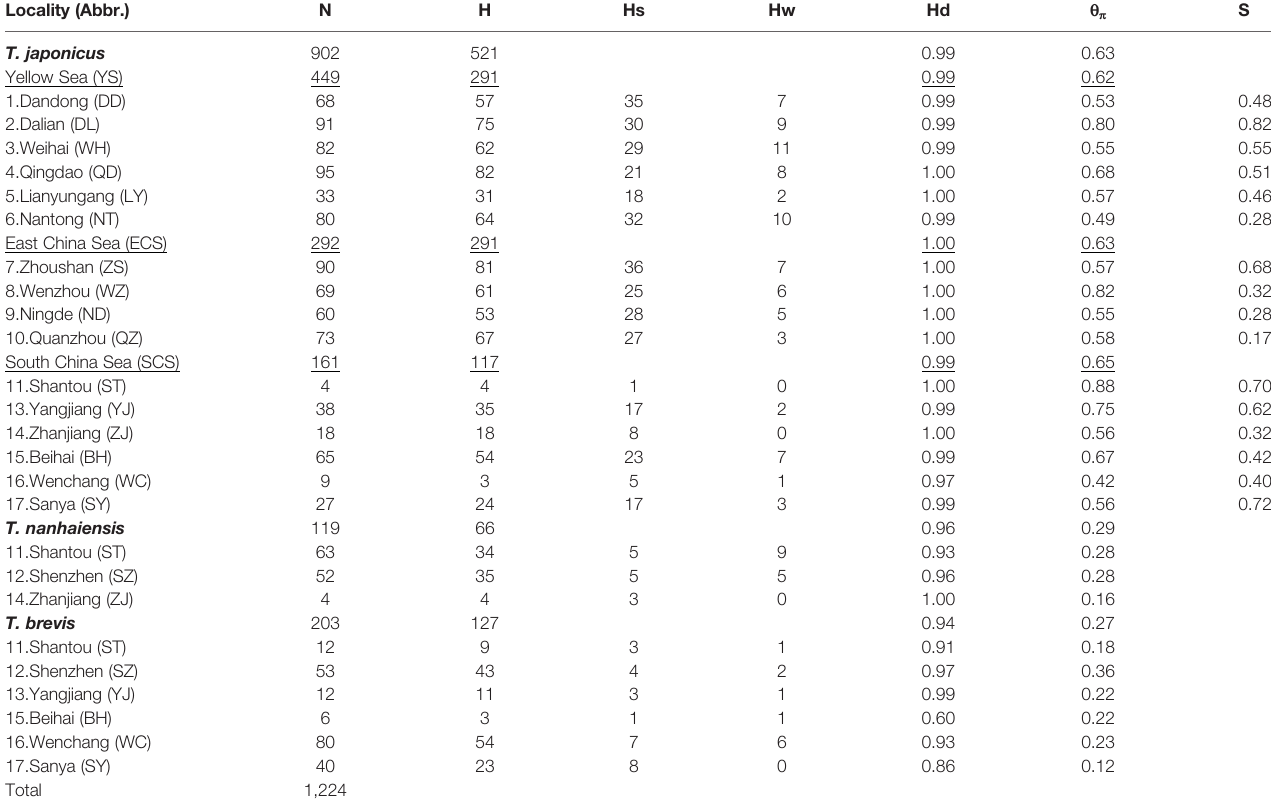
TABLE 1 | Genetic diversity in the species of the genus Trichiurus along China Seas. Locality